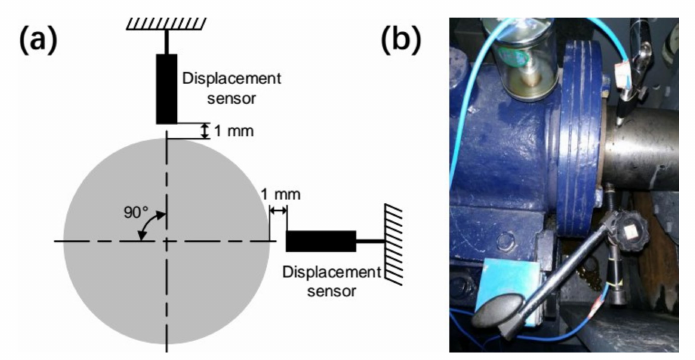
Figure 4. Eddy current sensors arrangement: ( a ) test section arrangement, ( b ) physical